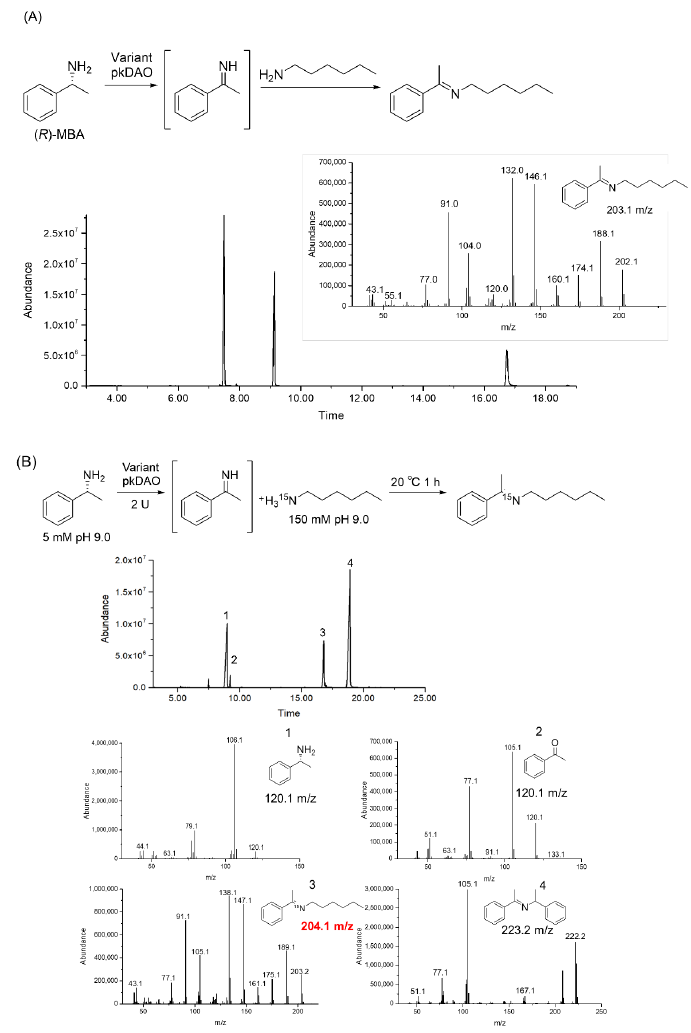
Figure 3. Reaction mechanism of new enzymatic method for the synthesis of imines by oxidation of ( R )-MBA with variant pkDAO using hexylamine ( A ) or 15 N-hexylamine ( B ).